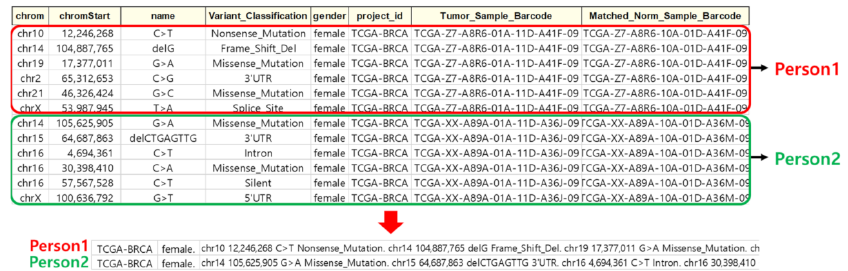
Figure 9. The process of converting an individual’s genome data into a single